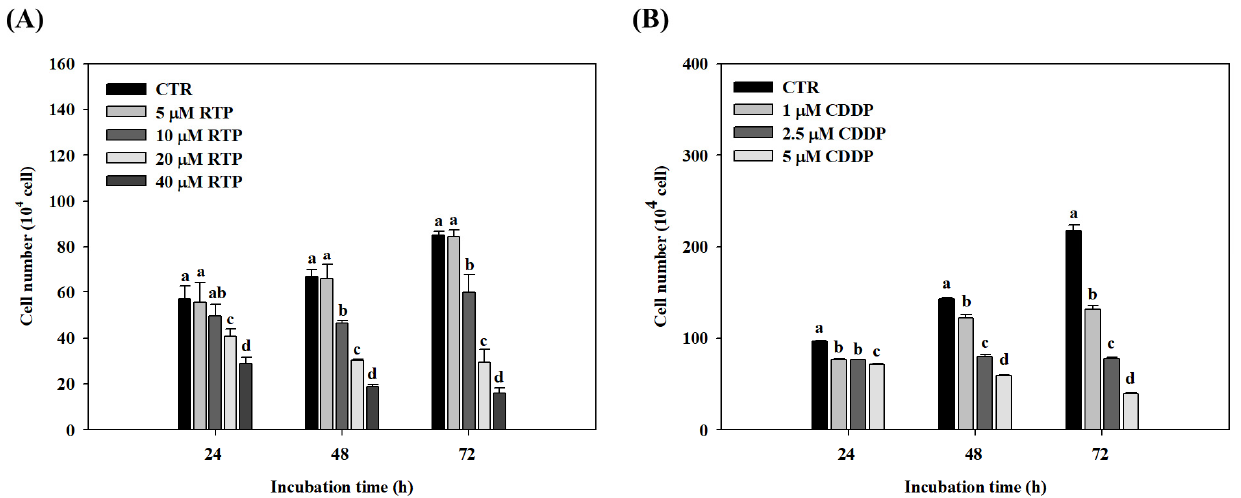
Figure 1. Effects of rutaecarpine (RTP); ( A ) and cisplatin (CDDP);( B ) on cell growth in human esophageal squamous cells CE81T/VGH. Cells were treated with RTP (5–40 µ M) or CDDP (1–5 µ M) for 24, 48, and 72 h. CTR represents the control group. Values (means ± SD, n = 3) within the same time interval not sharing a common lower case letter are significantly different from one another ( p < 0.05).